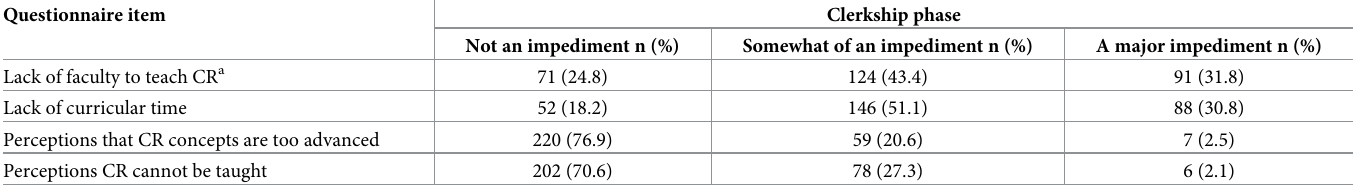
Table 4. Degree to which specific barriers impede the inclusion of clinical reasoning activities in the clerkship phase of medical school. Questionnaire